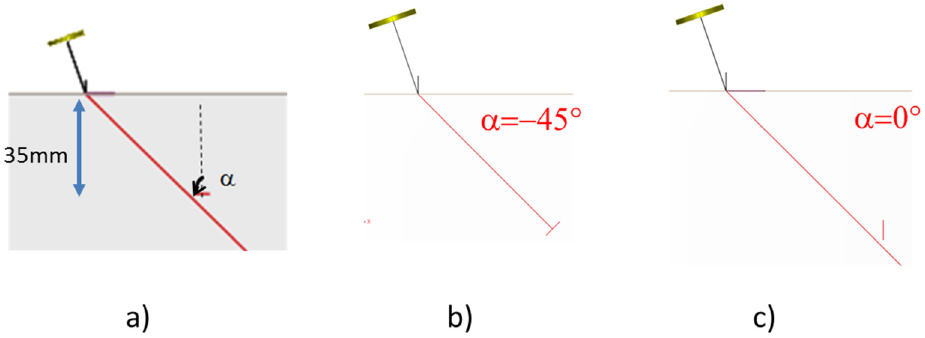
Figure 6. ( a ) pulse echo configuration with the SV45° wave at 5 MHz of a rectangular defect of varying height (5 mm here—red segment), 0.5 mm extent and various tilts; ( b ) α = − 45°, specular reflection configuration; ( c ) α = 0°, classical configuration of a vertical flaw.